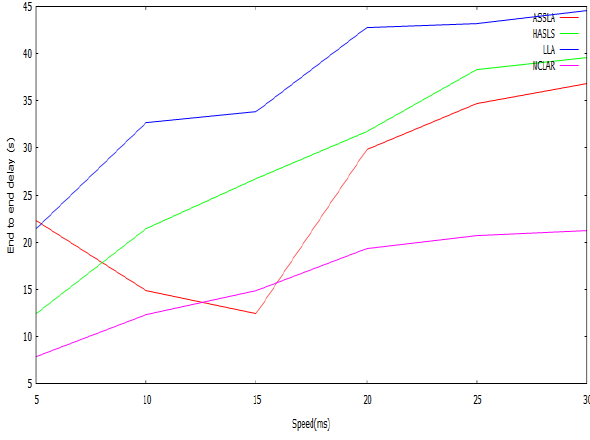
Figure 6 . End to end delay Vs Speed